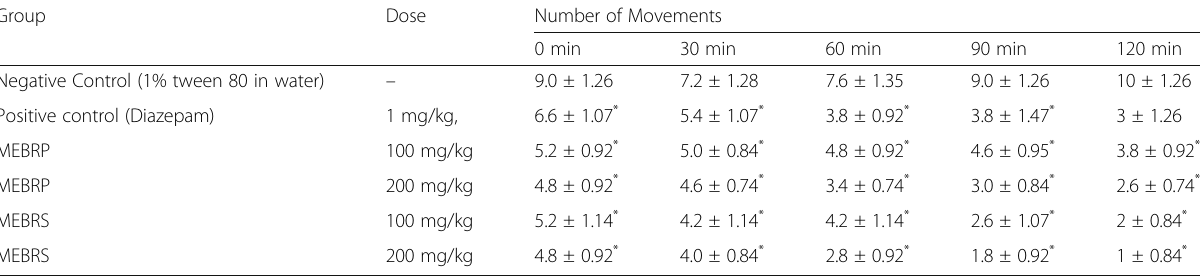
Values are means ± S.E.M. of five mice ( n =5) * p <0.05 considered as significant compared to control (Dunett ’ s test). Control mice received vehicle (1% Tween 80 in water), positive control mice